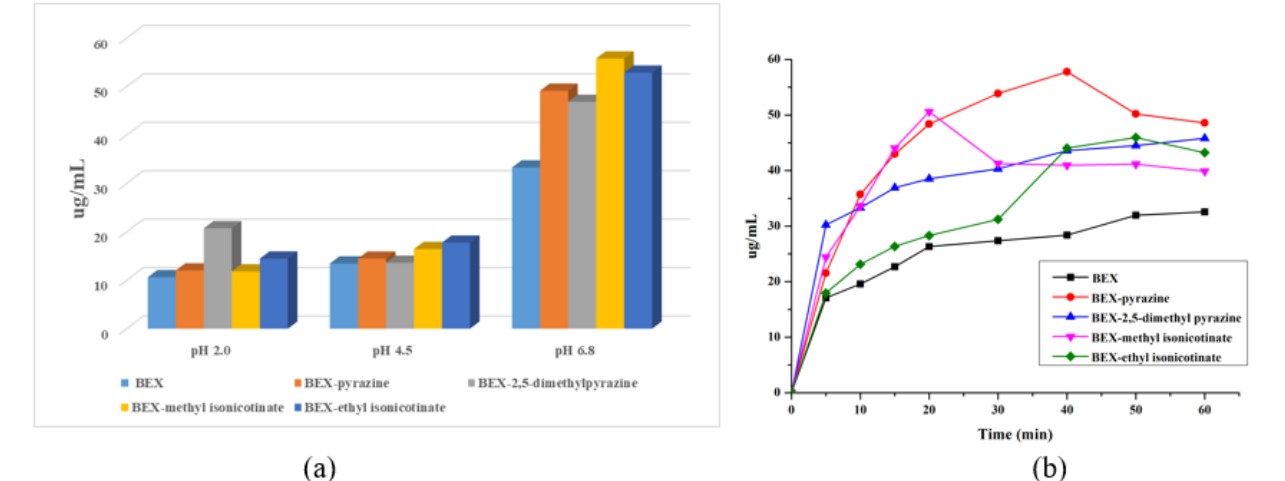
Figure 10. ( a ) Equilibrium solubility of BEX and cocrystals. ( b ) Powder dissolution of BEX and co- crystals at pH 6.8. The 0.05% CTAB was added in the buffer solution.